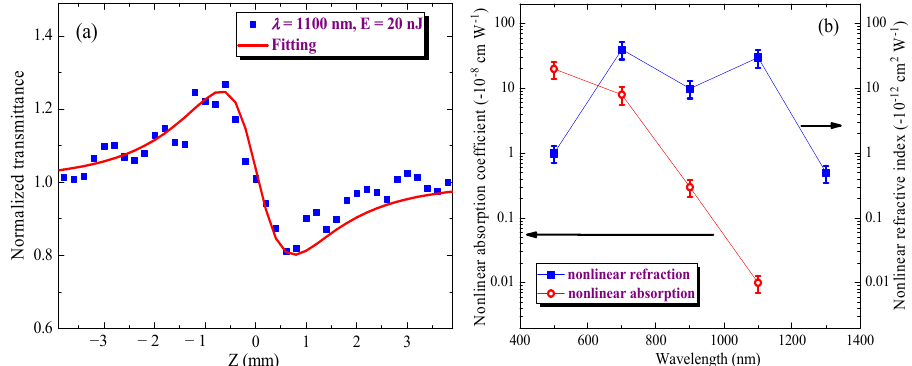
Figure 5. ( a ) Application of 500, 700, and 900 nm radiation for OA Z-scan studies of HgS QD film. ( b ) Variation of β at different energies of PP. Reprinted with permission from Ref. [31], 2022, MDPI. Below, the nonlinear optical studies of the HgS QDs HgS QDs suspensions and films using nanosecond pulses are discussed. The longer PPs allowed observation of the re- placement of the SA by the RSA in the extended (0.2 mm) medium (Figure 7a). The appli- cation of 532 nm pulses led to even stronger modification of the nonlinear absorption in this sample (Figure 7c). The scans shown in Figure 7c were fitted by standard procedure [33,34] to determine the corresponding SA and RSA processes ( β sat = − 6 × 10 − 8 cm W − 1 and β RSA = 5 × 10 − 7 cm W − 1 ). A similar parameter in the case of 1064 nm PP was derived using the same procedure ( β sat = − 4 × 10 − 9 cm W − 1 ).